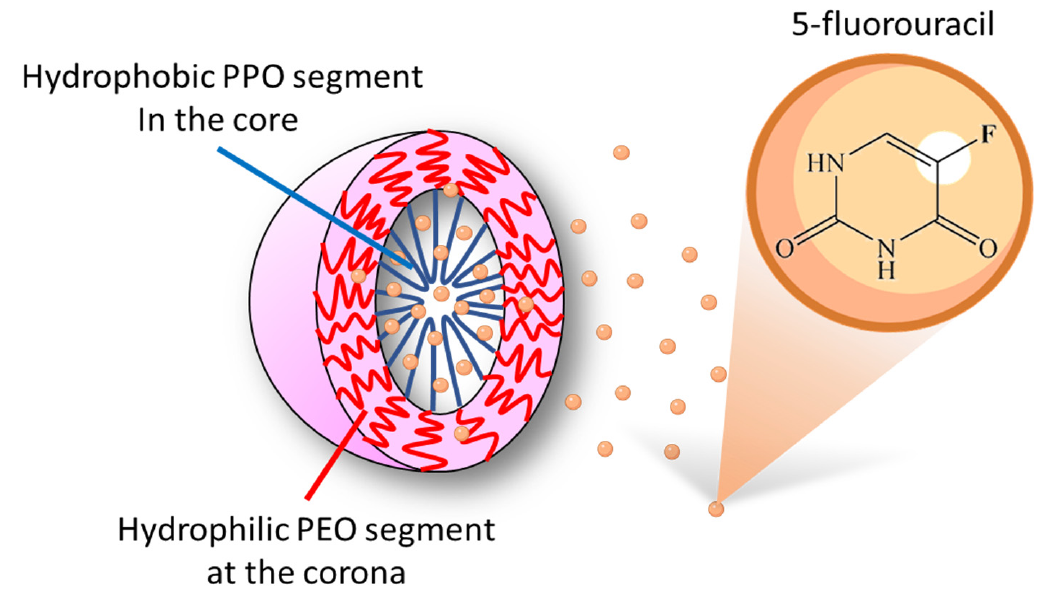
Figure 1. Schematic representation of the chemical structure of 5-Fluorouracil (5-FU). 5-FU medicine was loaded in the hydrophobic core of Pluronic micelles.